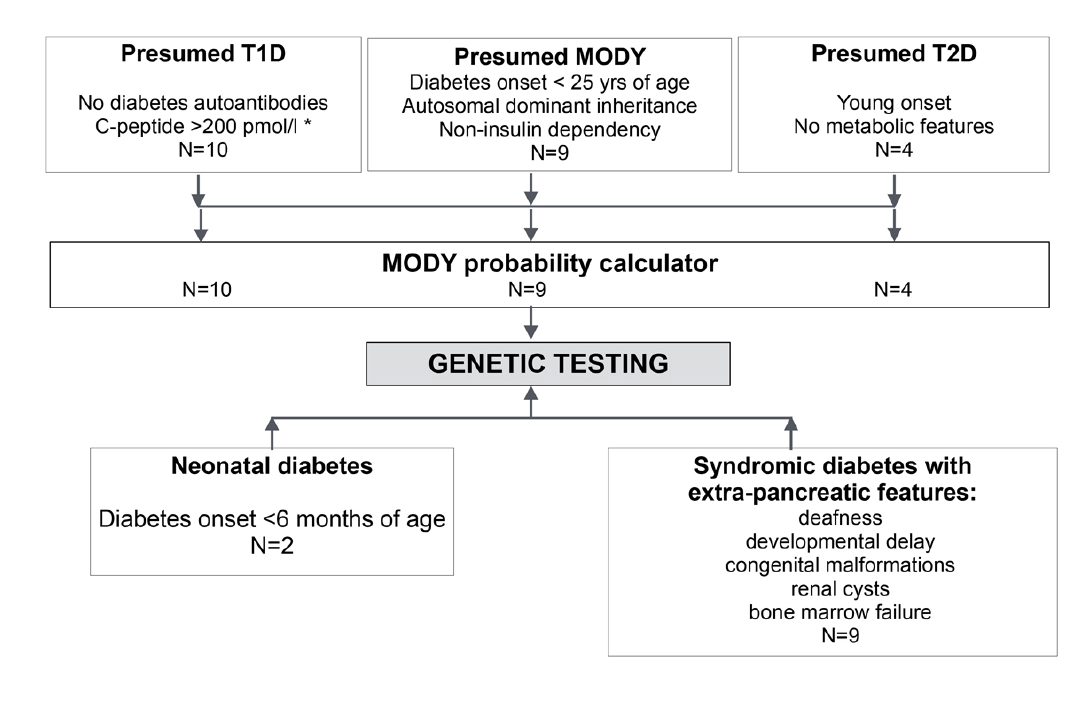
Figure 2: An updated pathway for clinical decision-making for monogenic diabetes screening.The MODY probability calculator will use clinical features from the three different groups with either presumed MODY or type 1 or type 2 diabetes to calculate the probability for monogenic dia- betes and therefore the indication for genetic testing. The calculator was developed for people with diabetes onset <35 years of age and should be used accordingly [10]. A direct molecular analysis is indicated for cases of neonatal and syndromic diabetes.*For presumed autoan- tibody negative type 1 diabetes cases, an additional indicator for genetic screening are persisting C-peptide levels after the honeymoon period of >200 pmol/l with glucose >8 mmol/l, to avoid suppression of C-peptide levels by hypoglycemia [31–33].We show the numbers of the geneti-